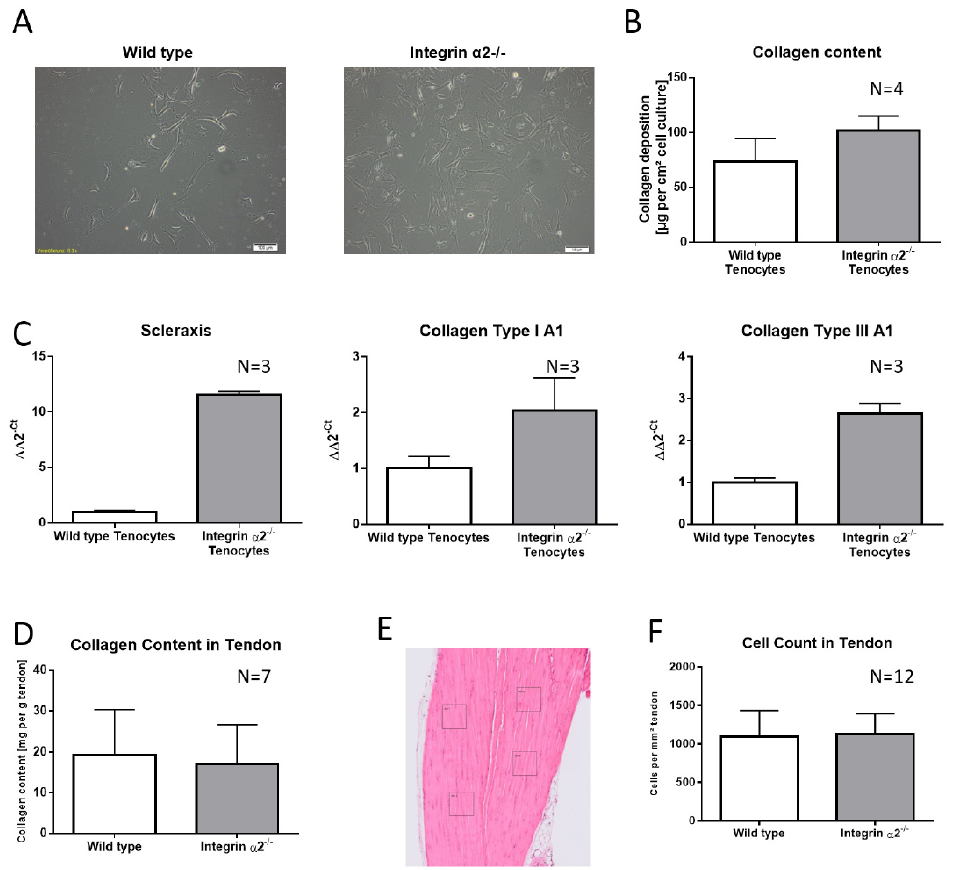
Figure 1. Collagen content differs in isolated cells compared to tendon tissue. Tenocyte-like cells isolated from the Achilles tendon of wild-type and integrin α 2 β 1-deficient mice ( A ). Total collagen content of the matrix produced by tenocytes after 3 weeks of culture ( B ). qPCR analysis of key genes in isolated tenocytes ( C ). Total collagen quantification of wild-type and integrin α 2 β 1-deficient Achilles tendons from 4-month-old female mice ( D ). HE staining of a representative longitudinal slice of an Achilles tendon with the cell quantification pattern ( E ). Cell quantity in situ ( F